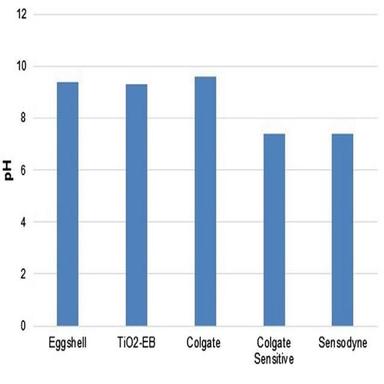
pH of commercial toothpastes, eggshell and TiO2-EB.